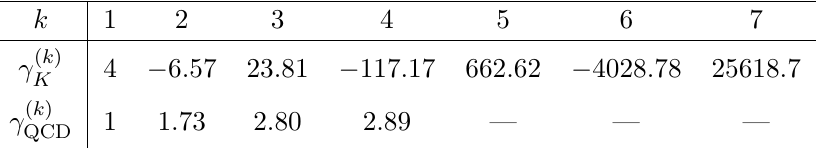
Table 2 . The first few terms in the perturbative series of the cusp anomalous dimension for planar N = 4 SYM, eq. (4.3), and QCD, eq. (4.5).